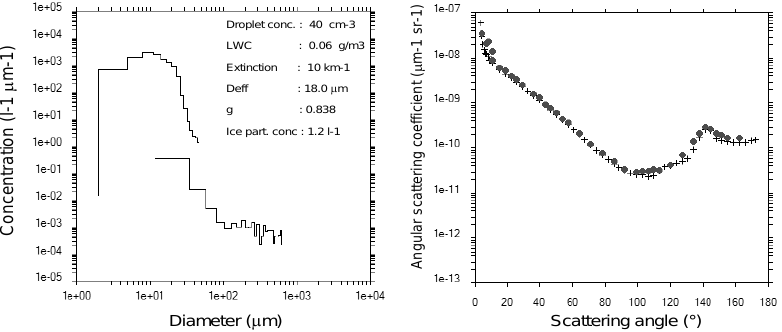
Fig. 3b. Liquid water-phase cloud properties. Right panel: Mean scattering phase function measured by the Polar Nephelometer (circle symbols) and scattering phase function obtained by Mie theory (cross symbols) calculated with the average droplet size distribution measured by the FSSP-100 over the same time-period. Left panel: FSSP-100 and CPI mean size-distributions. Are also reported the mean values of the pertinent microphysical and optical parame- ters (Cloud droplet concentration, LWC: liquid water content, extinction coefficient, Deff: effective diameter, g : asymmetry parameter). The concentration of ice particles calculated from the CPI is also indicated.